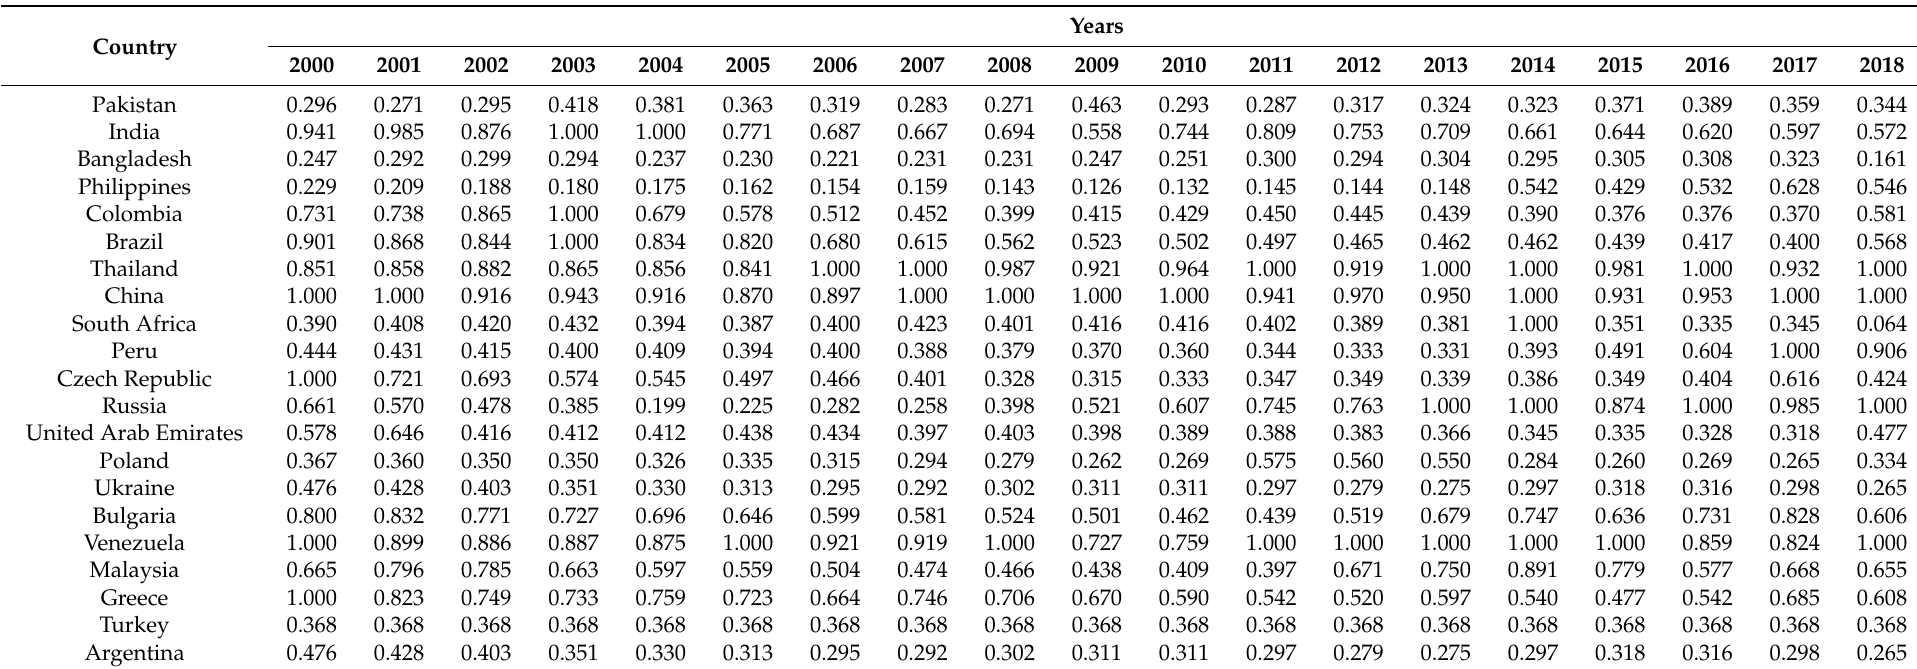
Table 4. Health efficiency scores for the selected emerging